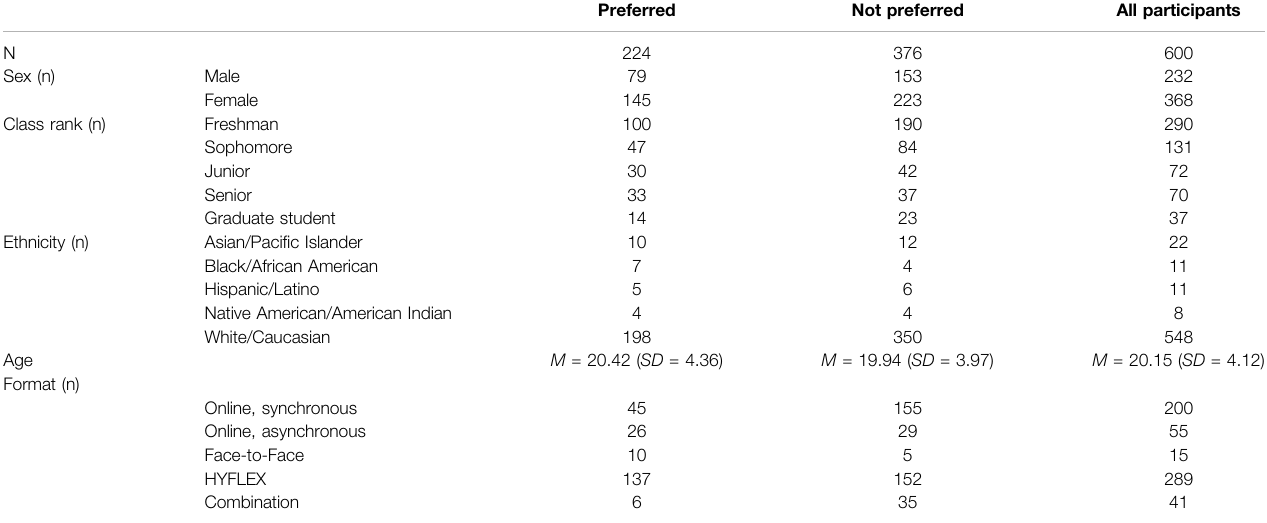
TABLE 2 | Fit statistics.